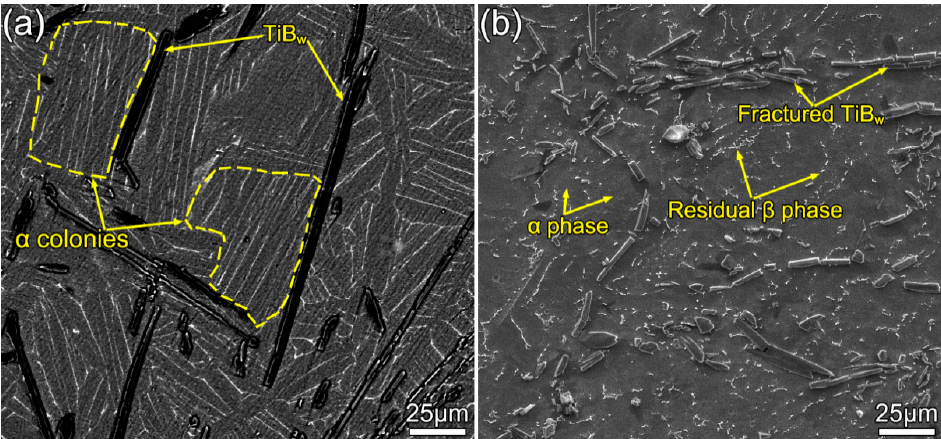
Figure 3. The microstructure of the TiB w /Ti composite: ( a ) as-cast composite and ( b ) as-forged composite.